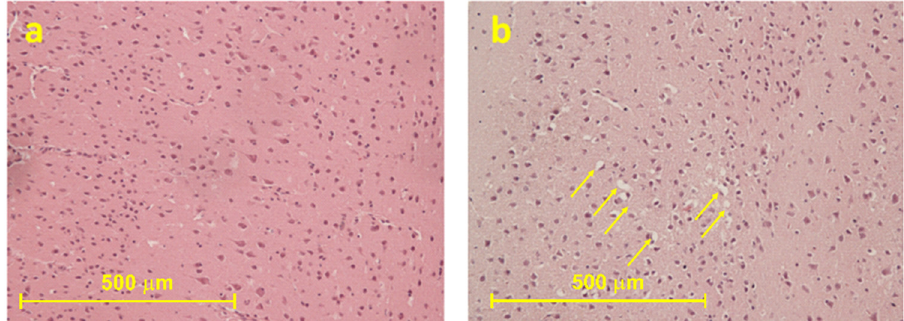
Figure 2. The frontal cortex of the treated mice ((±) cis 30; ( b ) showed mild edema (i.e., vacuolization areas are indicated by yellow arrows) compared to controls ( a ).